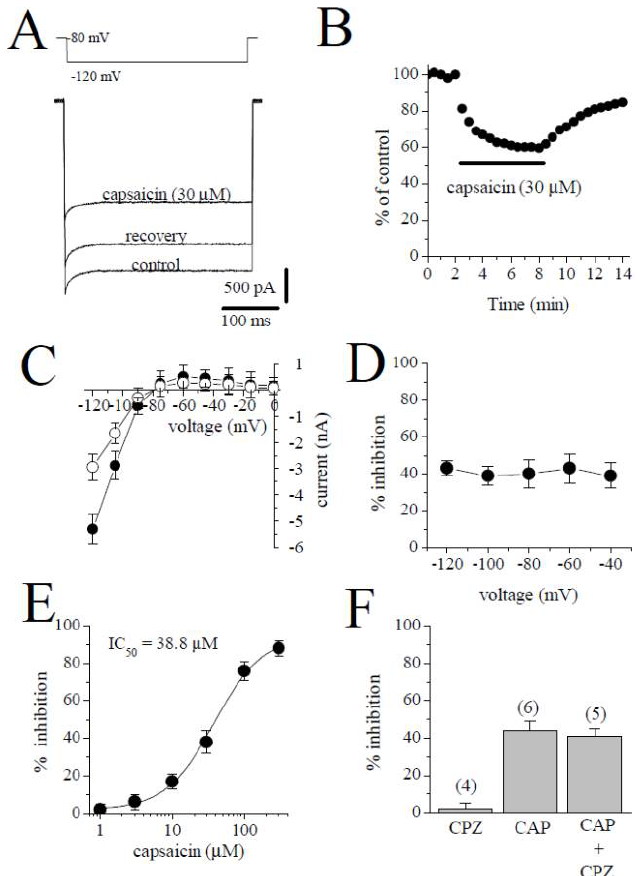
Figure 6. The effect of capsaicin on I K1 . ( A ) Traces of I K1 obtained in control after 6 min exposure to 30 µM capsaicin and recovery. The pulse protocol to activate I K1 is presented as an inset. ( B ) Time course of the effect of capsaicin effect on I K1 and washout presented as % of control calculated from the mean of three control currents. ( C ) Current–voltage relationships of I K1 in the absence and presence of 30 µ M capsaicin were presented with filled and open circles, respectively ( n = 5). ( D ) The relationship between test potential and the capsaicin (10 µM) inhibition of I K1 ( n = 5; p > 0.05, ANOVA). ( E ) The effect of increasing concentration of capsaicin on I K1 ( n = 4–6). ( F ) The effect of capsazepine (3 µM) and the extent of capsaicin (30 µM) inhibition of I K1 in the absence and presence of 3 µM capsazepine. The number of cells tested for each group was presented on top of each bar ( p > 0.05; t -test).